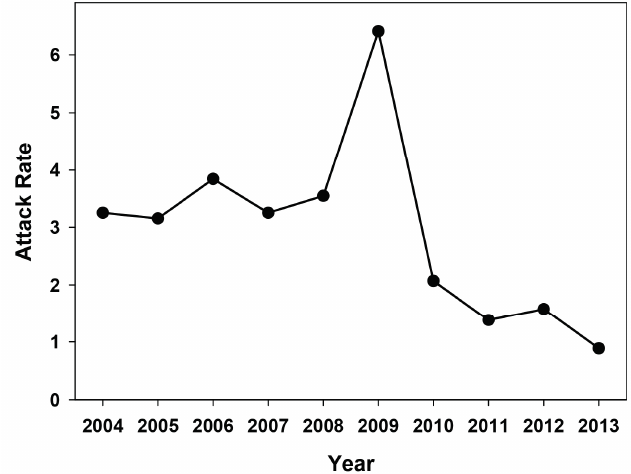
Figure 1. Hepatitis A attack rates in the decade 2004–2013 in Catalonia, Spain, in the context of a universal vaccination campaign for preadolescents at the age of 12 years. Data is distributed in natural years. Attack rates are defined as the number of cases per 100,000 inhabitants.